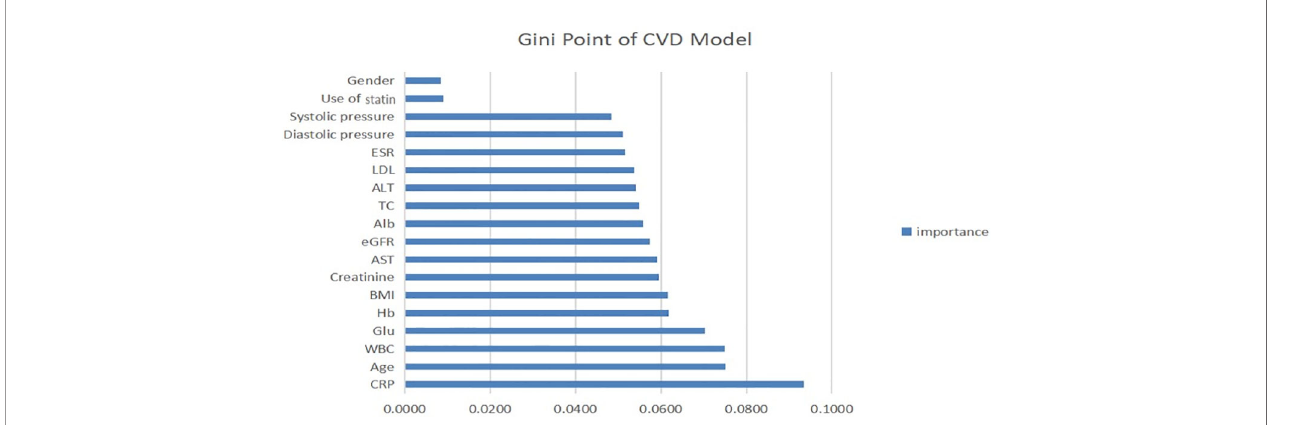
FIGURE 4 | Contribution of predictors of CVD index in CKD patients with micro-in fl ammation. ALT, serum alanine transaminase; AST, serum aspartate transaminase; Alb, serum albumin; TC, total cholesterol; Glu, blood glucose; Hb, haemoglobin; ESR, erythrocyte sedimentation rate; BMI, body mass index; WBC, white blood cells; hsCRP, hypersensitive C-reactive protein; eGFR, estimated glomerular fi ltration